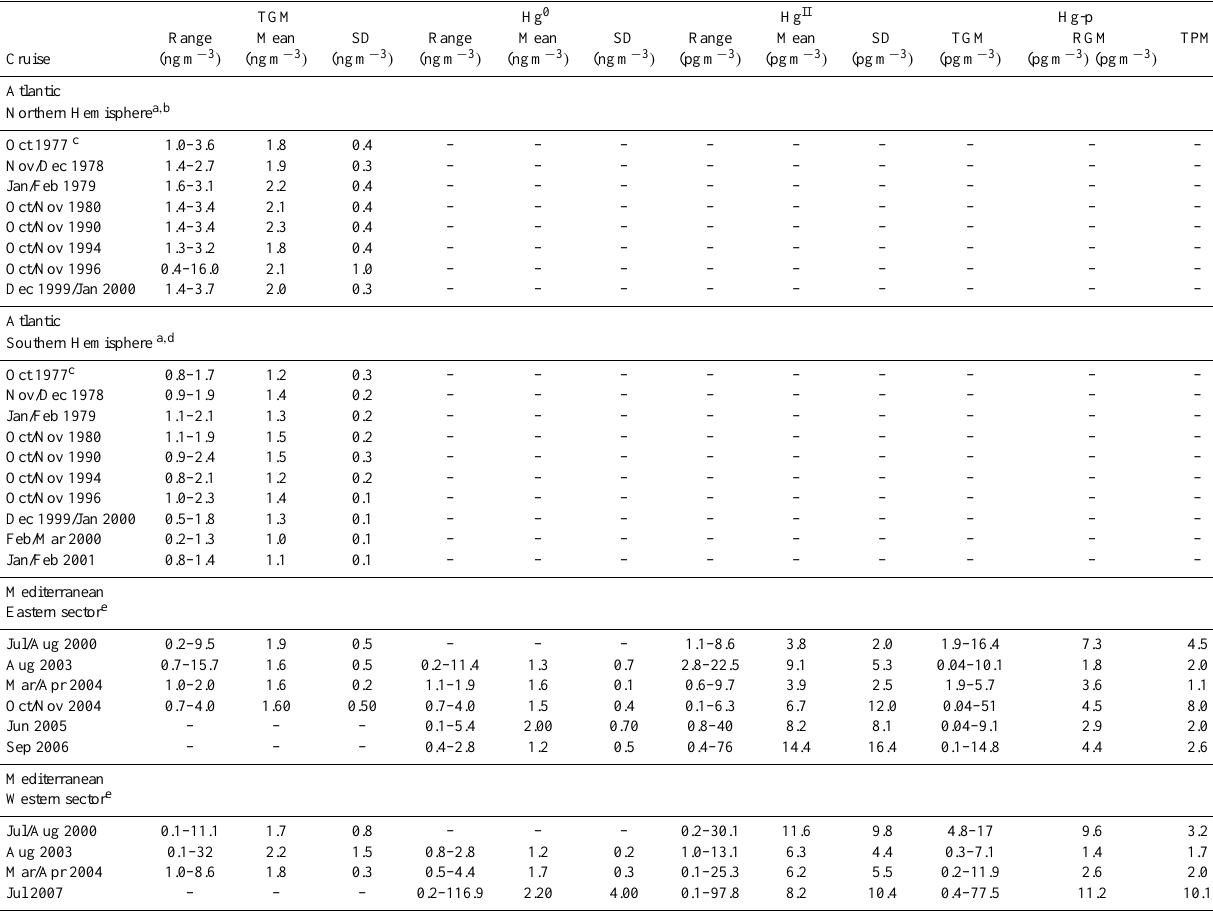
Table 2. Over waters TGM, Hg 0 , Hg II and Hg-p data observed in the Atlantic Ocean and Mediterranean sea during seasonal campaigns performed from 1977 to